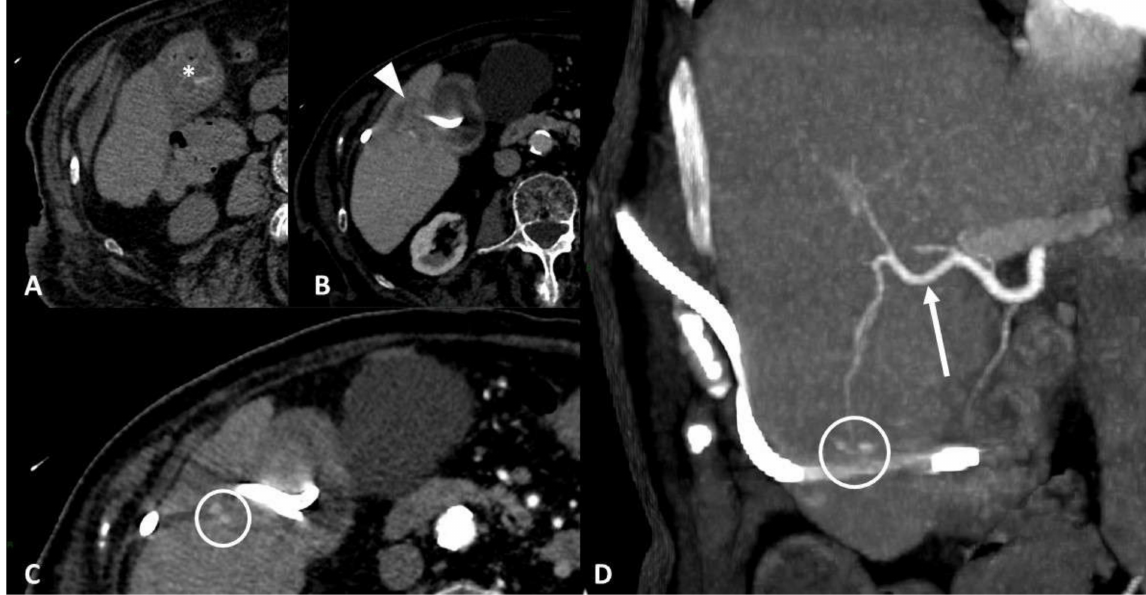
Figure 6. Vascular injury. Seventy-five-year-old patient affected by bleeding after percutaneous cholecystostomy. Axial non-enhanced CT scan ( A ) shows hyperdense blood-like material inside the gallbladder (*). Contrast-enhanced CT scans ( B , C ) show liver parenchymal laceration (arrowhead) in segment V, next to gallbladder, with two hyperdense spots inside. Maximum intensity projection coronal image ( D ) shows more clearly two pseudoaneurysms of a distal branch of the right hepatic artery (arrow) along drainage